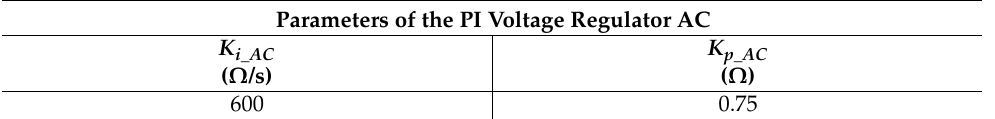
Table 2. Parameters of the PI voltage regulator AC.